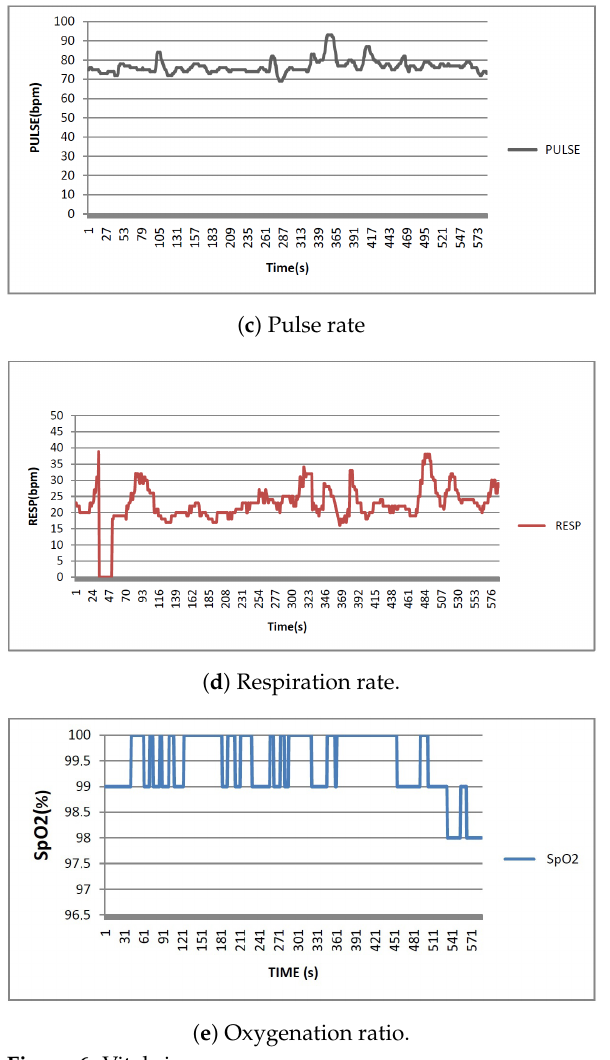
Figure 6. Vital signs.